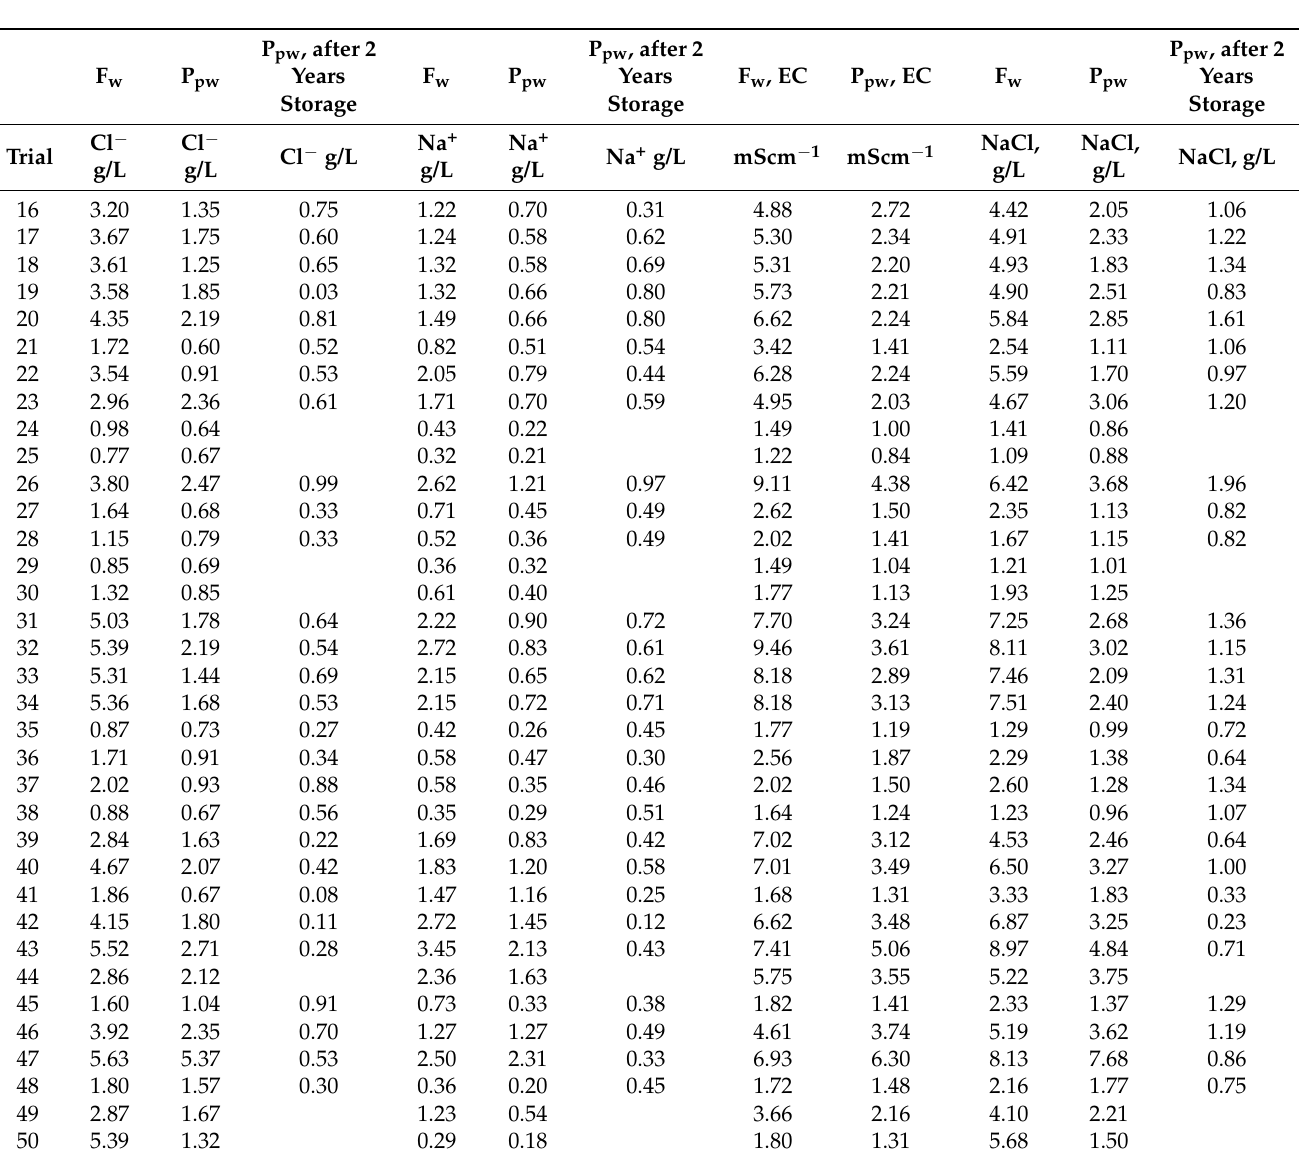
Table A3. Desalination rate constant decline analysis, measured values of k insf , p , and R 2 associated with ion removal. The values measured from a regression plot of k obsf vs. reaction time ( a (hours)). k obsf = ( − Ln ( C t=n / C t= 0 ))/( t = n ). C t= 0 = ion concentration at t = 0. C t=n = ion concentration at t = n . ( t = n ) = time spent in the reaction environment, seconds = 3600 a . Decline curve type = power function; exponential (exp) function, natural logarithmic function; linear function. Power relationship: k obsf = k insf ( a ) p ; linear relationship: k obsf = k insf ( a ) + p ; logarithmic relationship: k obsf = k insf × Ln( a · p